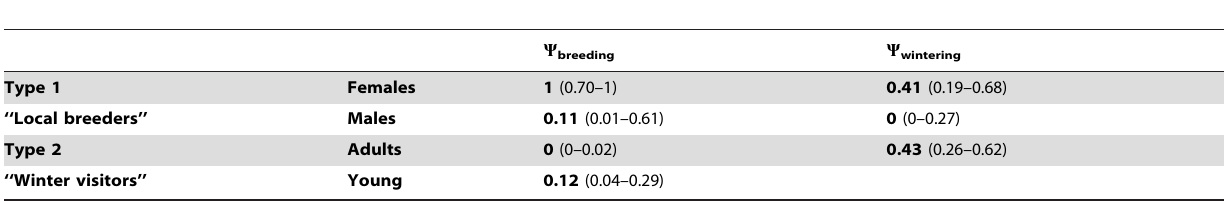
Table 2. Seasonal probabilities of presence on Grand-Lieu ( Y breeding , Y wintering ) by pochards according to type (‘‘local breeder’’ versus ‘‘winter visitor’’), age (young versus adult) or sex, derived form the selected